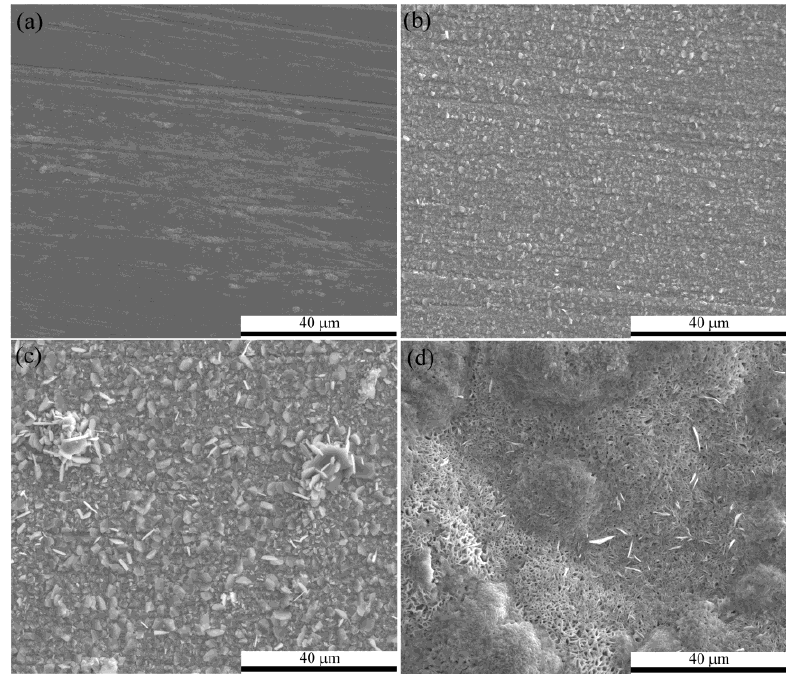
Figure 2. Surface morphologies of the flat scales formed on P92 after 24 h oxidation in pure oxygen at ( a ) 600 °C; ( b ) 700 °C; and ( c ) 800 °C; ( d ) Top-view image of surface nodules formed in pure oxygen at 800